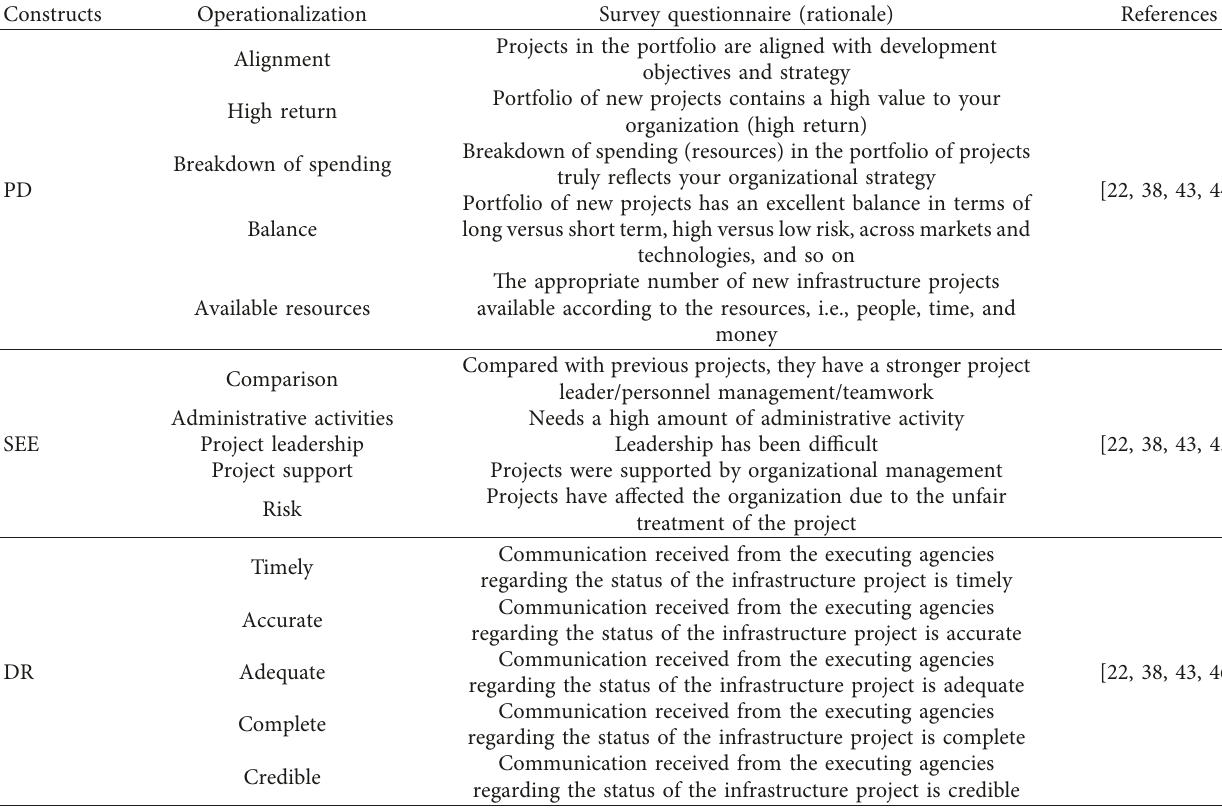
Table 1: Operationalization of constructs and survey